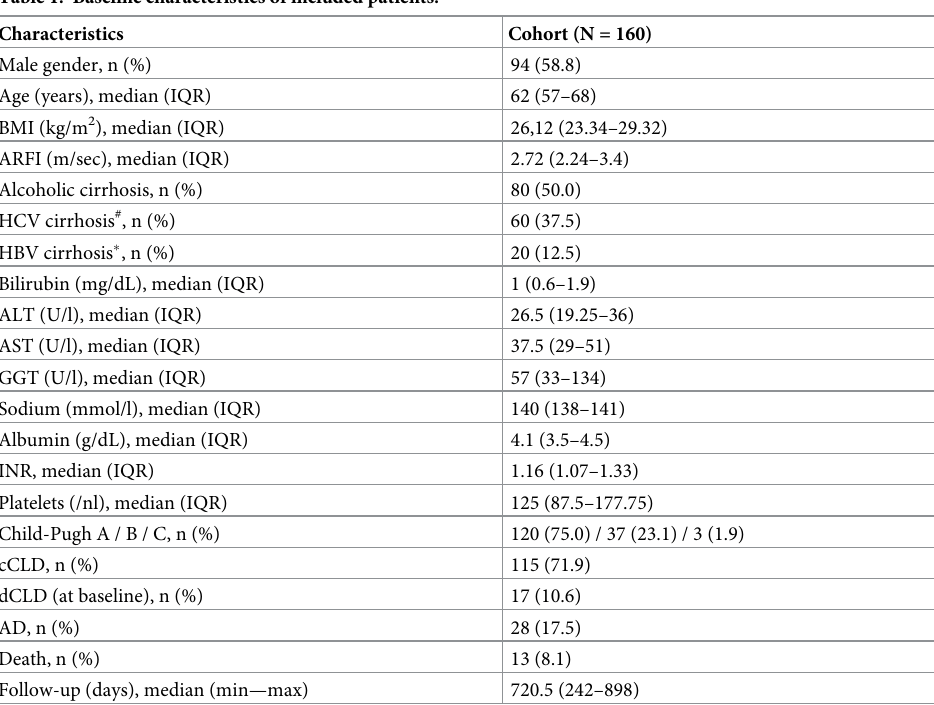
Table 1. Baseline characteristics of included